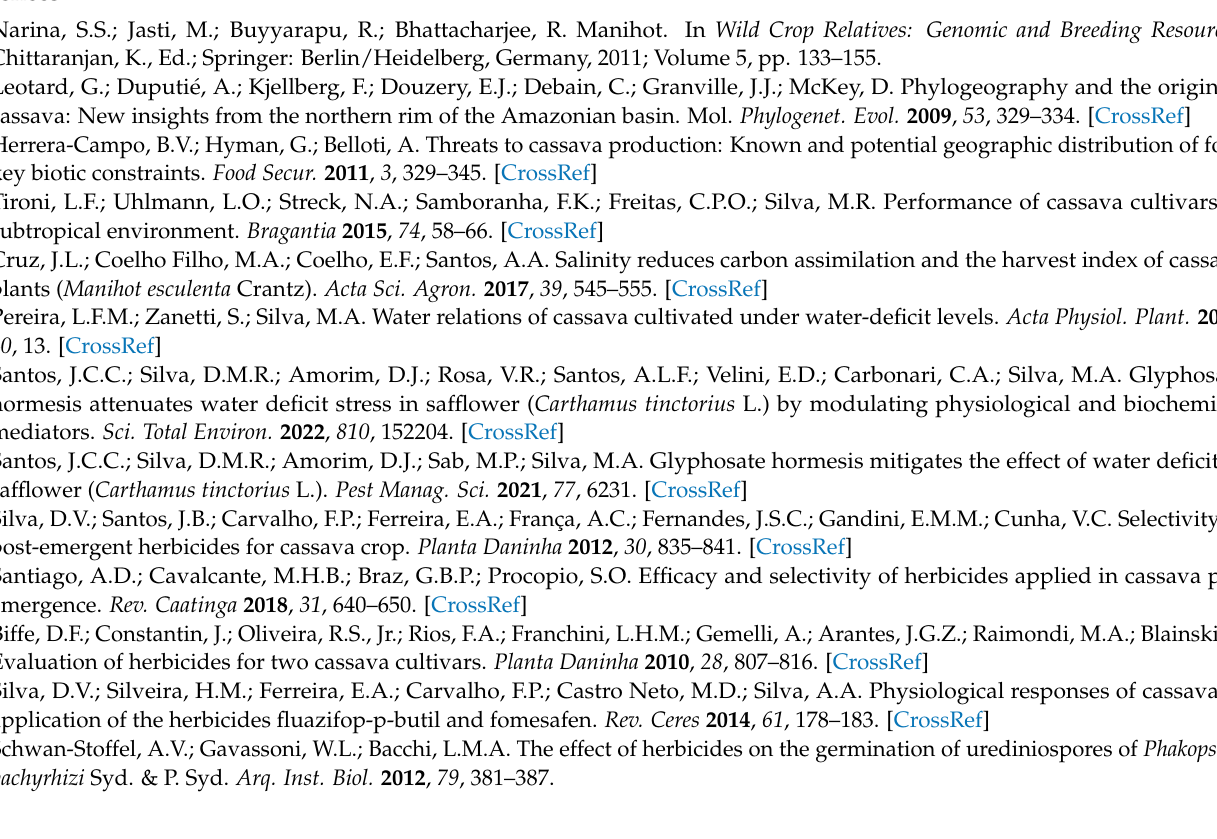
Table S2: Relative frequency (Rf). relative density (Rd). relative dominance (RDo) and importance value index (IVI) of weed species in the culture of M. esculenta